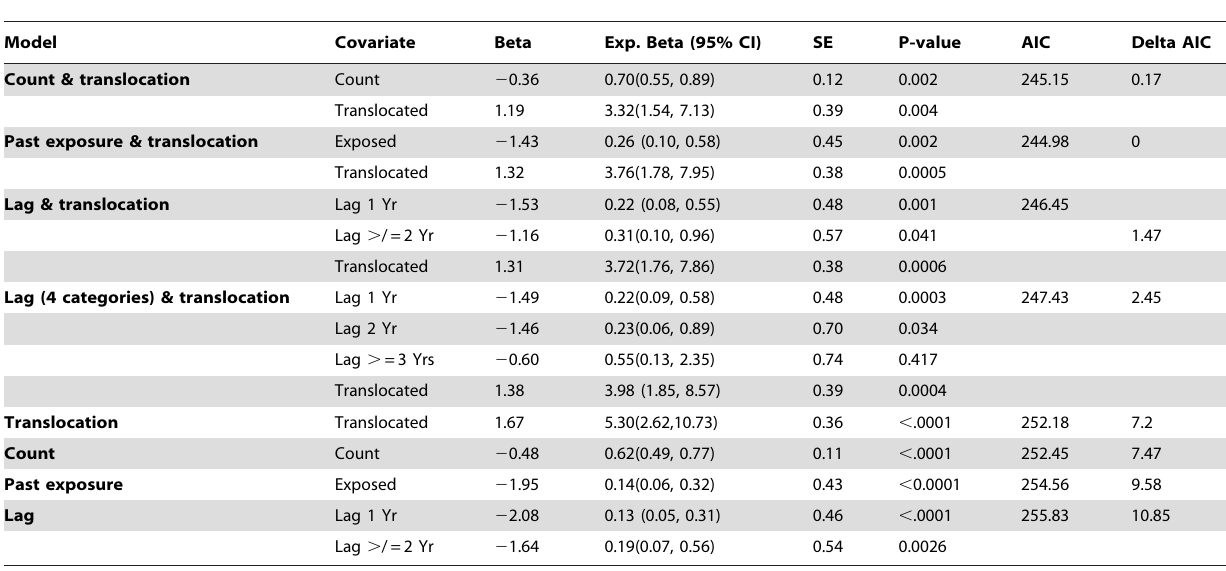
Table 3. Ewes: results from Cox proportional hazards model of ewe relative risk of dying from pneumonia given covariates over the age-based timescale.